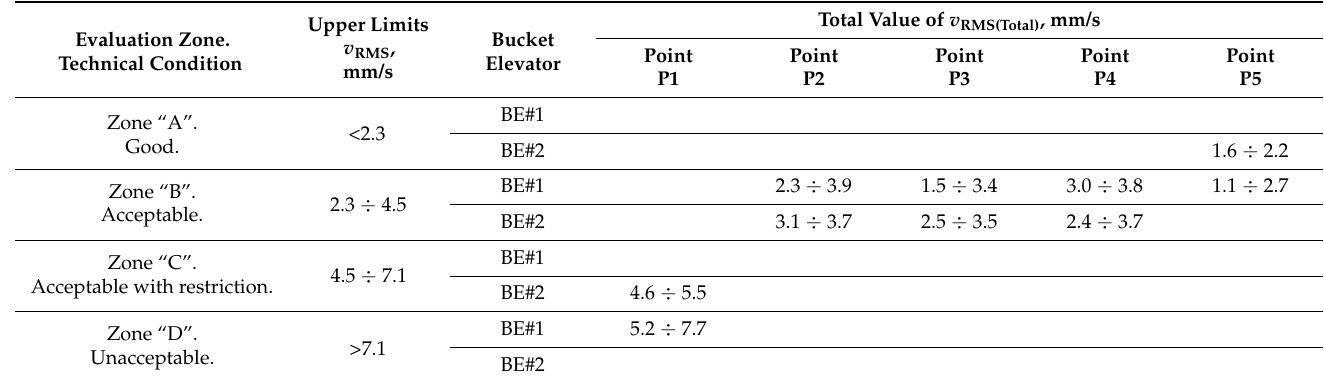
Upper Limits v RMS , mm/s